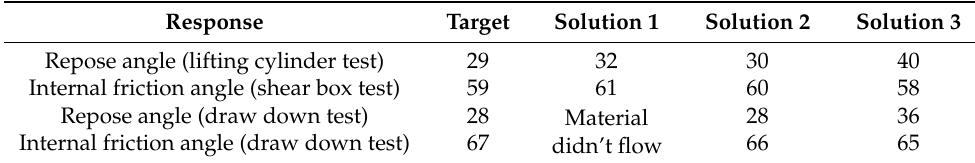
Table 7. Simulated parameters, including the best fit given by Solution